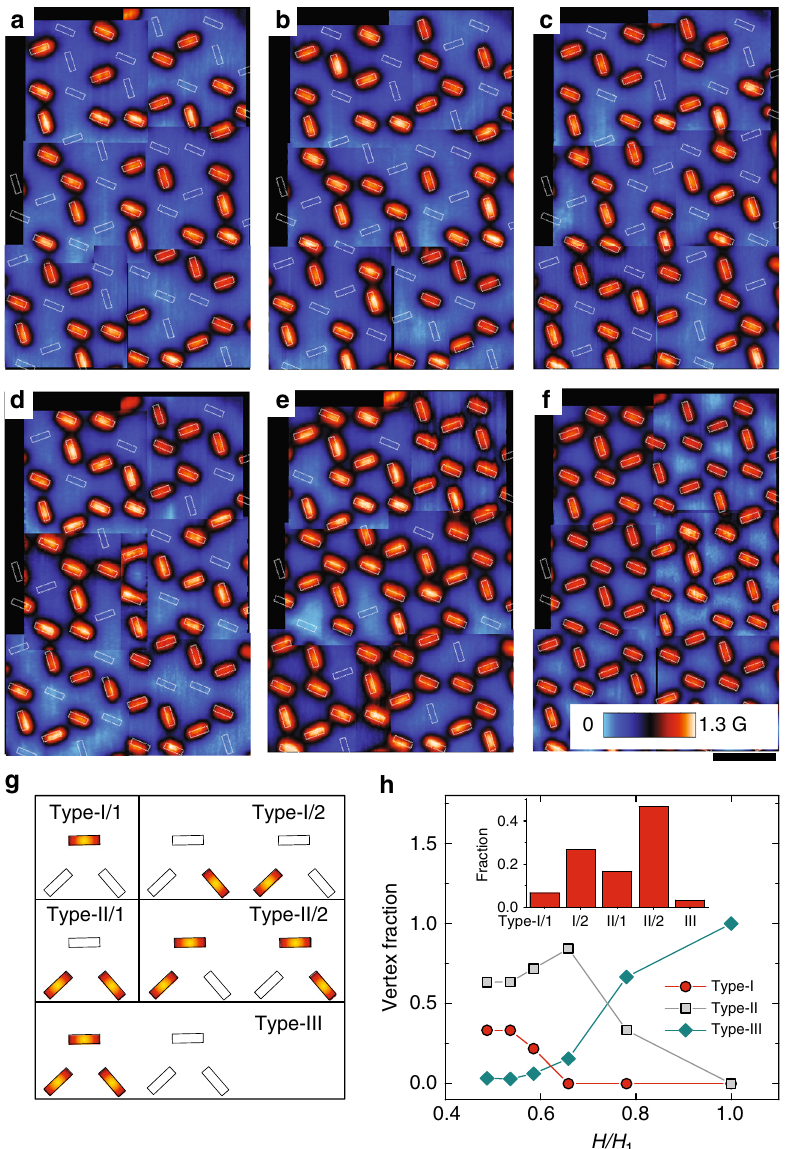
Fig. 4 Vortex lattice evolution with magnetic fi eld. a – f Vortex lattice observed at 4.2 K and different applied magnetic fi elds 0.49 H 1 ( a ), 0.54 H 1 ( b ), 0.59 H 1 ( c ), 0.66 H 1 ( d ), 0.78 H 1 ( e ) and H 1 ( f ). Scale bar, 4 μ m. g Schematic view of various unit con fi gurations. h Statistics of vertex con fi gurations in vortex ice. The inset histogram shows the distribution of various types at H = 0.49 H